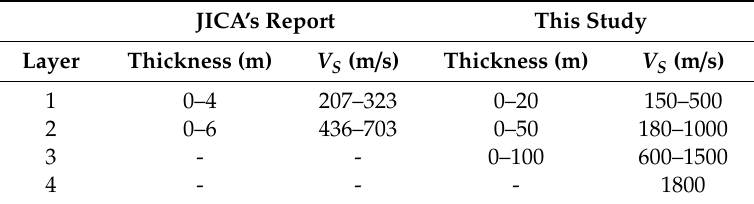
Table 4. Initial inversion parameter of the typical site (UB25). JICA’s Report This